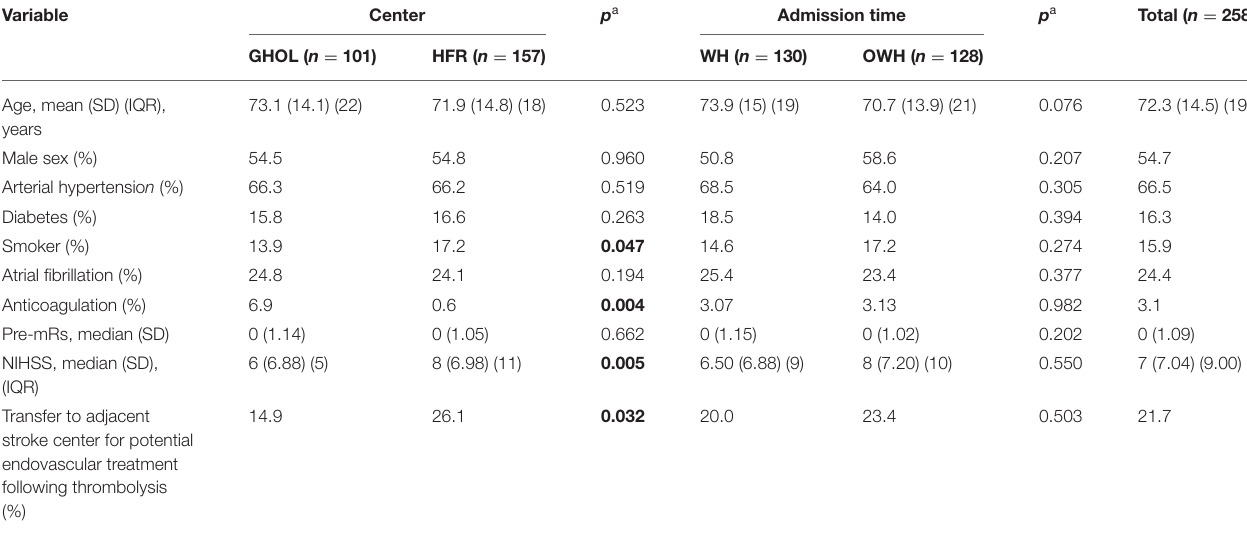
TABLE 1 | Site-specific demographics and clinical characteristics; demographics and clinical characteristics as per admission time. Variable